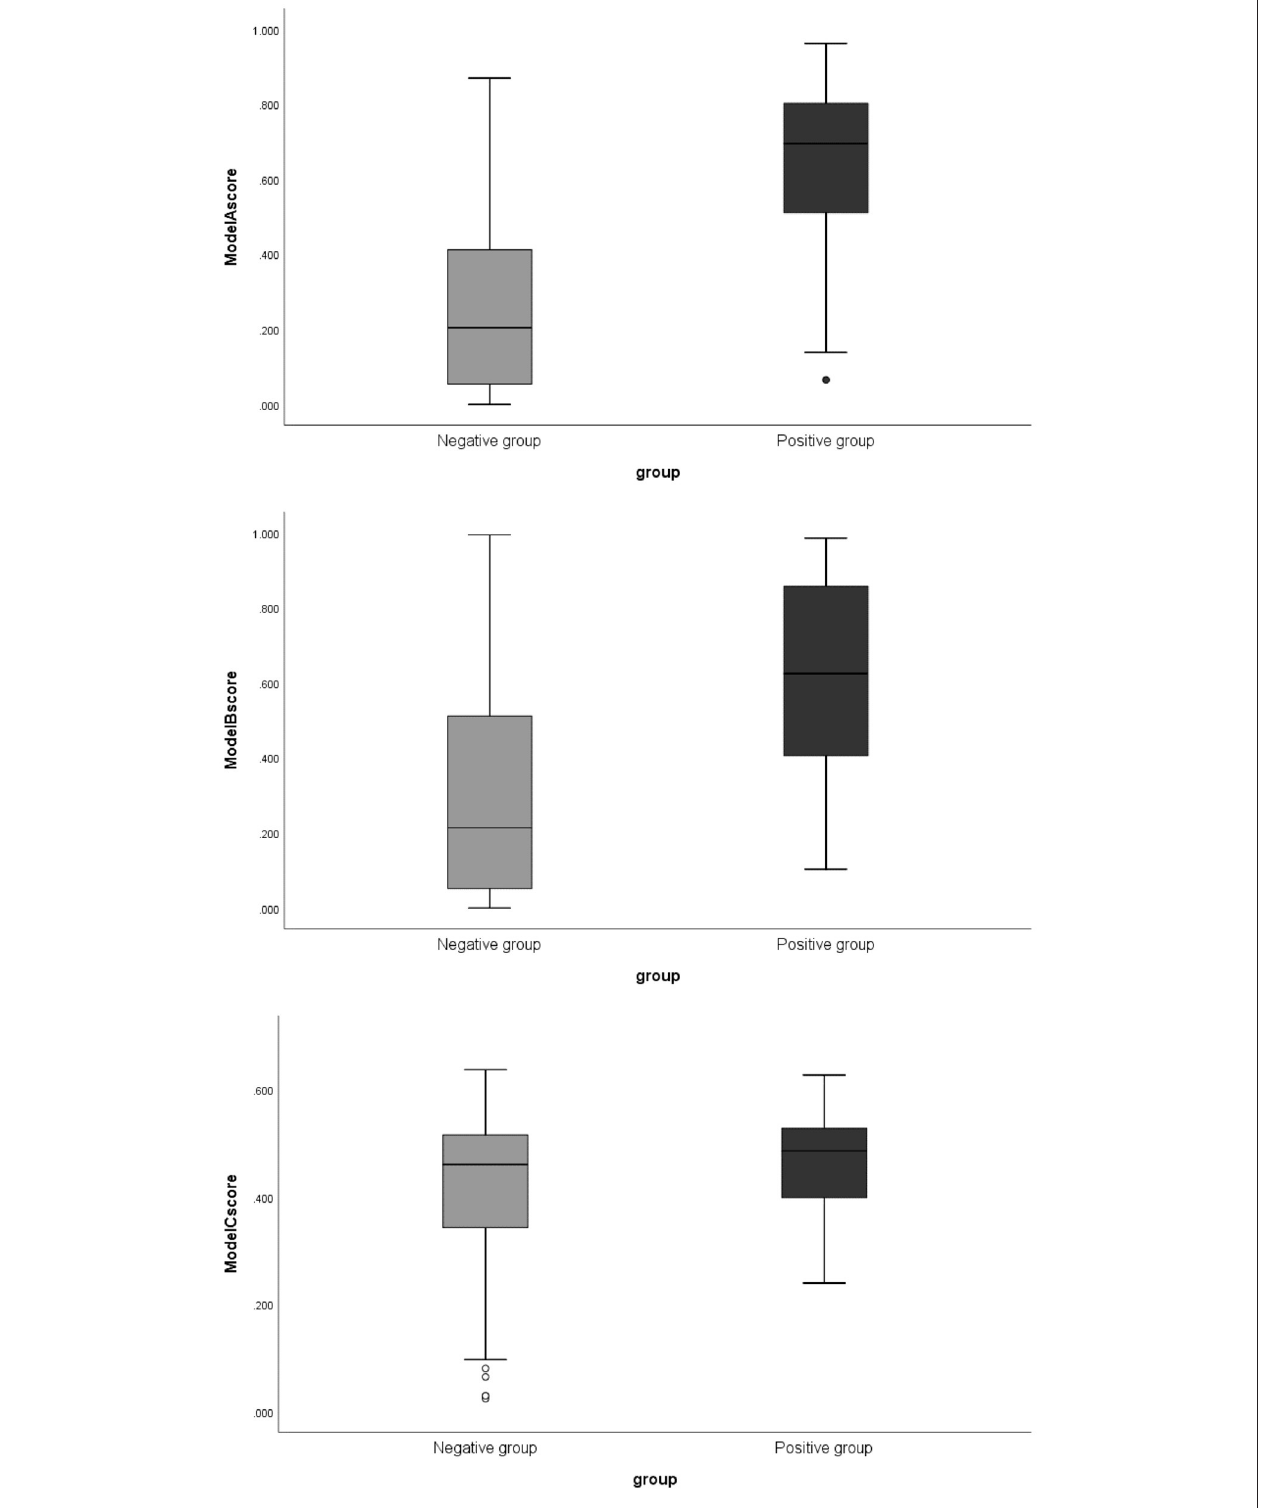
FIGURE 2 | The boxplots of corresponding scores of 3 models comparing negative and positive groups. Model A, model of traditional morphological features; Model B, model of Radiomics derived features; Model C, model of Radiomics derived morphological features.